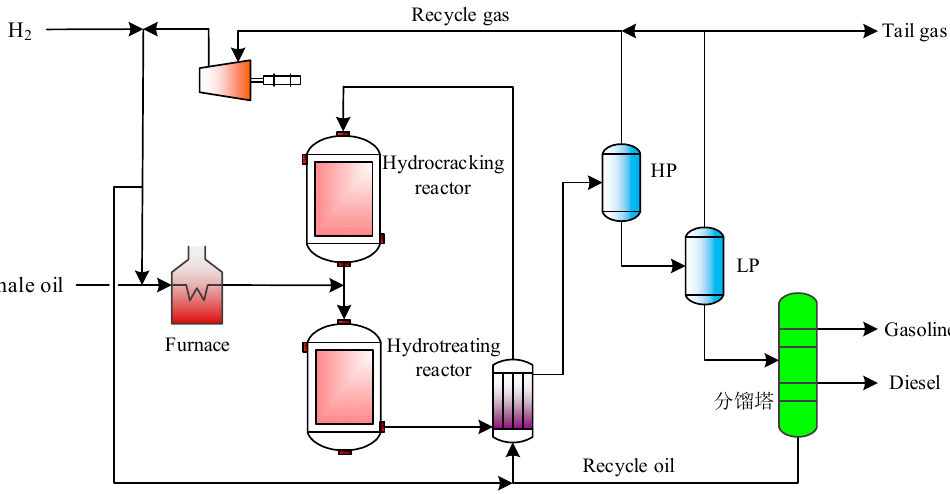
Figure 7. Flow diagram of shale oil full fraction hydrogenation.